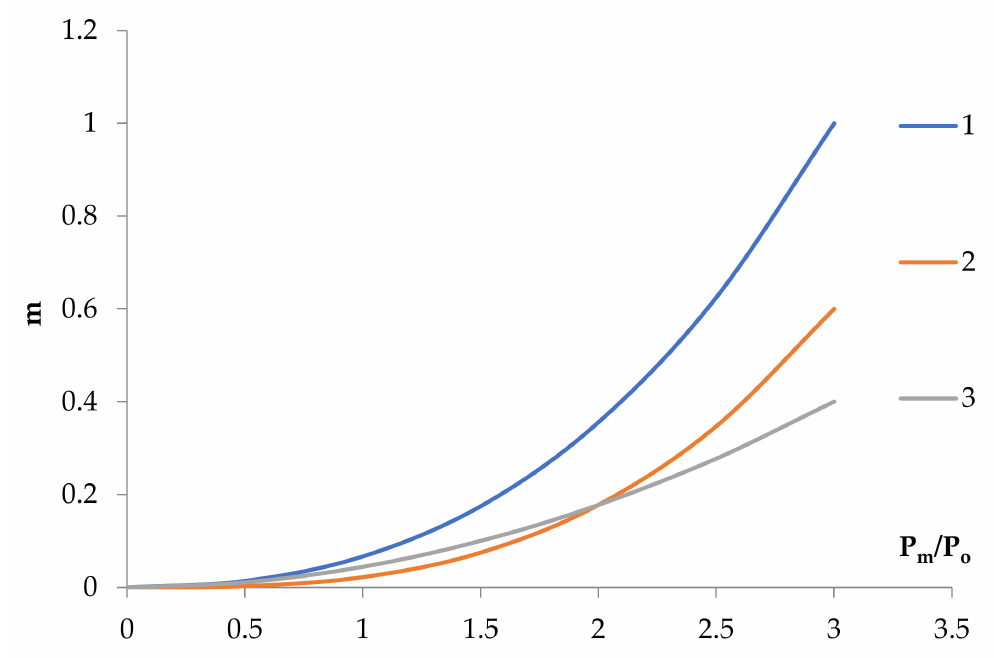
Figure 4. Dependence of metal oxide powder mass on ultrasound intensity for the same period of processing (normalized form): 1—mass of metal oxide dissolved in efficient US erosion conditions; 2—amount of metal oxide shredded by US erosion; 3—dissolution of metal oxide in the absence of eroded